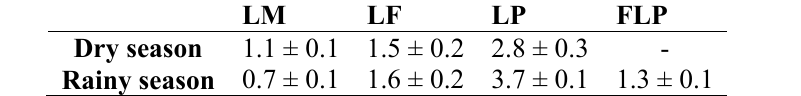
Table 1. Content (% w/w) of the volatile oil of the three species of Leptospermum on dried matter .